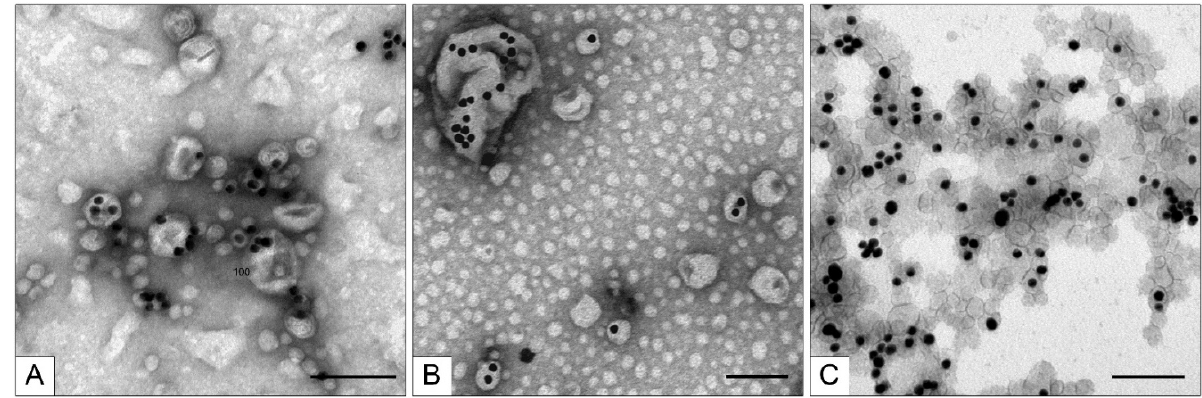
Figure 4. Ultrastructure of the obtained MLNCs. ( A ) Assembly in 100 mM phosphate buffer, ( B ) assembly in 10 mM phosphate buffer, and ( C ) assembly in 1 mM phosphate buffer. The scale bars correspond to 100 nm. Negative staining with a 0.5% uranyl acetate solution followed by TEM. Table 1. Physicochemical parameters of MLNCs at different concentrations of phosphate buffer (PB).